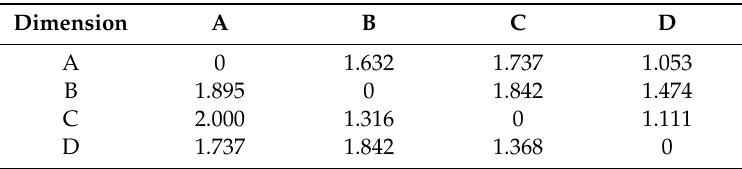
Table 4. Average matrix A D of dimensions.